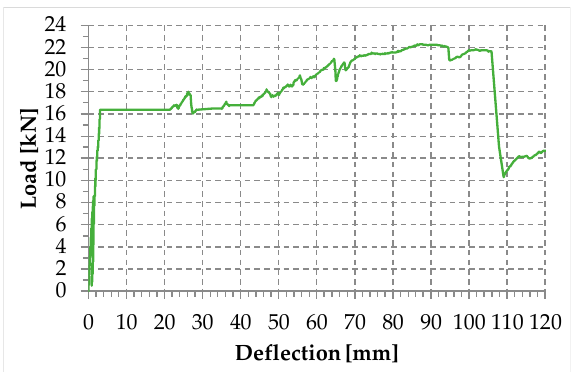
Figure 11. Load/deflection diagram for the first combined technique, in a hypothetical flexural test performed in the load control.